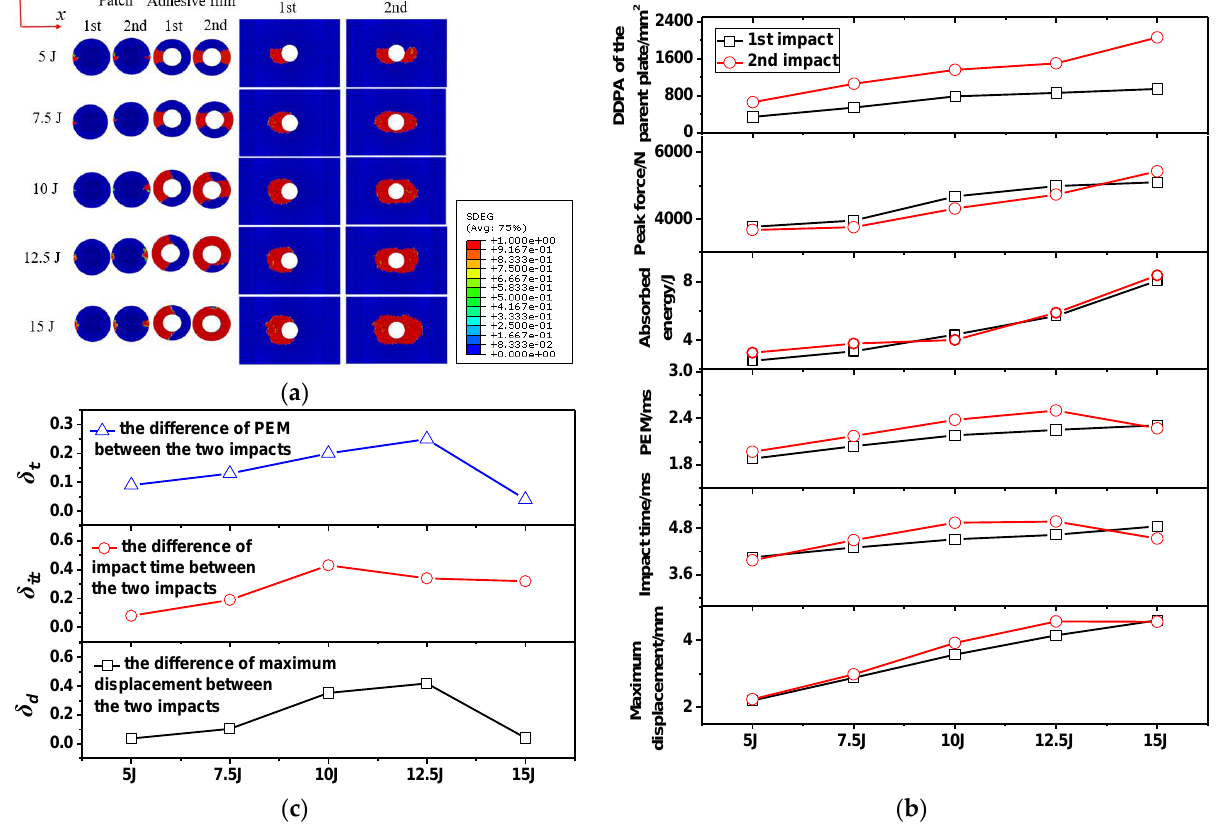
Figure 17. Delamination damage diagrams of the repaired specimen ( a ), impact parameter curves under double impacts at the impact distance of 25 mm, with the impact energy of 5 J–15 J, ( b ) and difference curves of the impact parameters (c) .